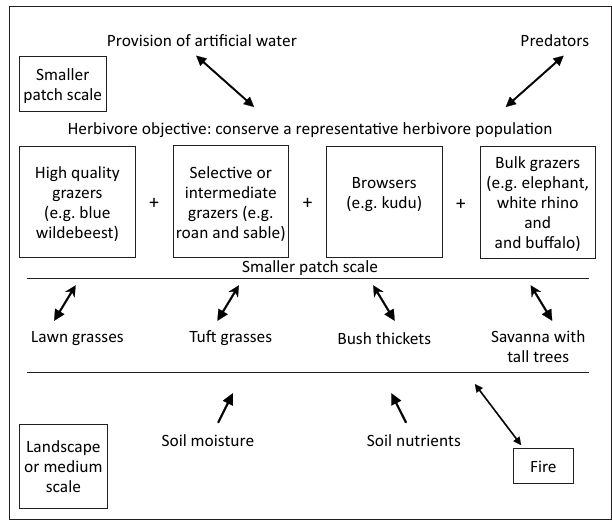
FIGURE 2: An illustration of the interaction between herbivores and the ecological influences of soil moisture and nutrient distribution at the medium or landscape scale. At smaller spatial and temporal scales, soil moisture and nutrients interact with other factors such as water distribution and predators to affect herbivore population and